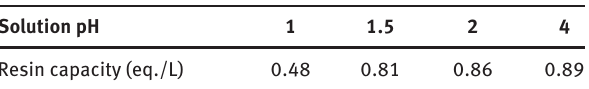
Table 2: Capacity of the resin depending on solution pH, with a 5.87 g/L Ni